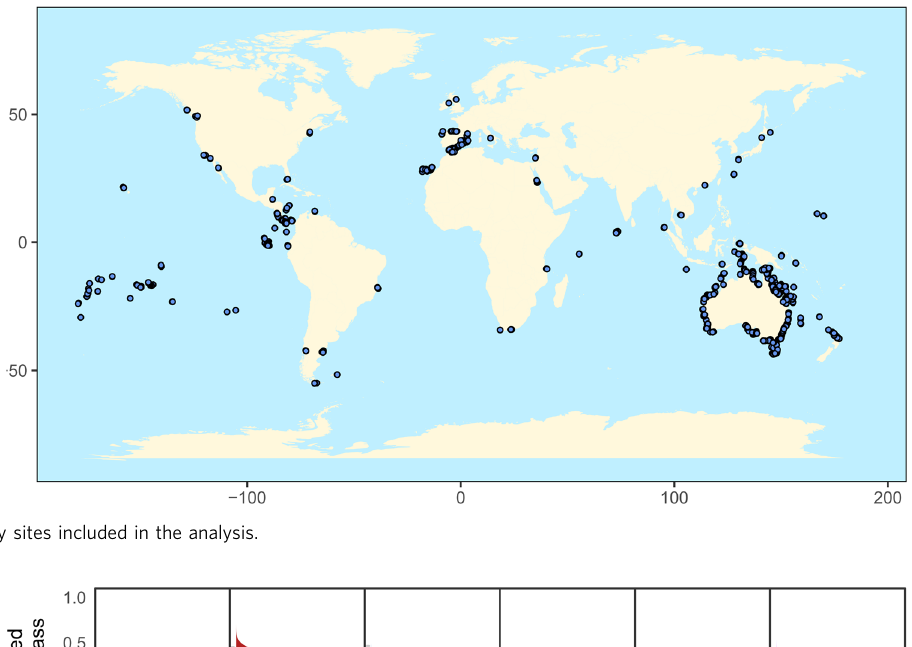
Fig. 2 A map of study sites included in the analysis.